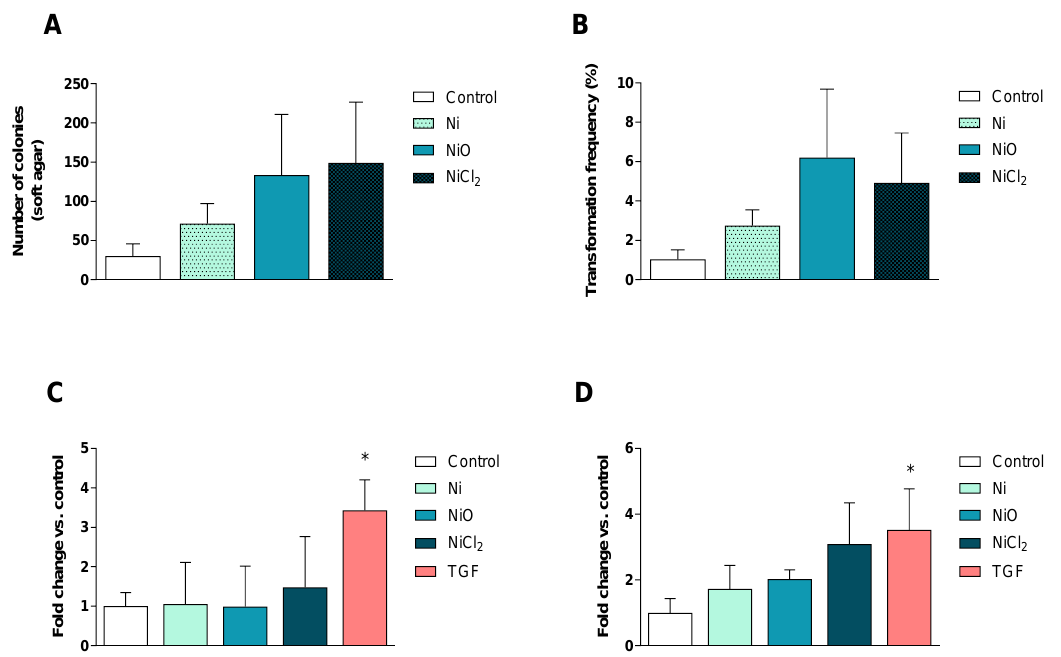
Figure 7. Cell transformation and motility. ( A – B ) Soft agar cell transformation was determined after 6 weeks of exposure. Results are expressed as total number of colonies ( A ) as well as the overall transformation frequency ( B ) in which the colony-forming efficiency was considered (mean ± S.D., n = 3). Cell migration ( C ) and invasion ( D ) was evaluated after 6 weeks of exposure and results are expressed as fold change compared to the control presented as mean ± S.D. ( n = 3). Positive control: TGF β , 15 ng / mL 72 h. Significant results are marked with asterisks (* p -value <